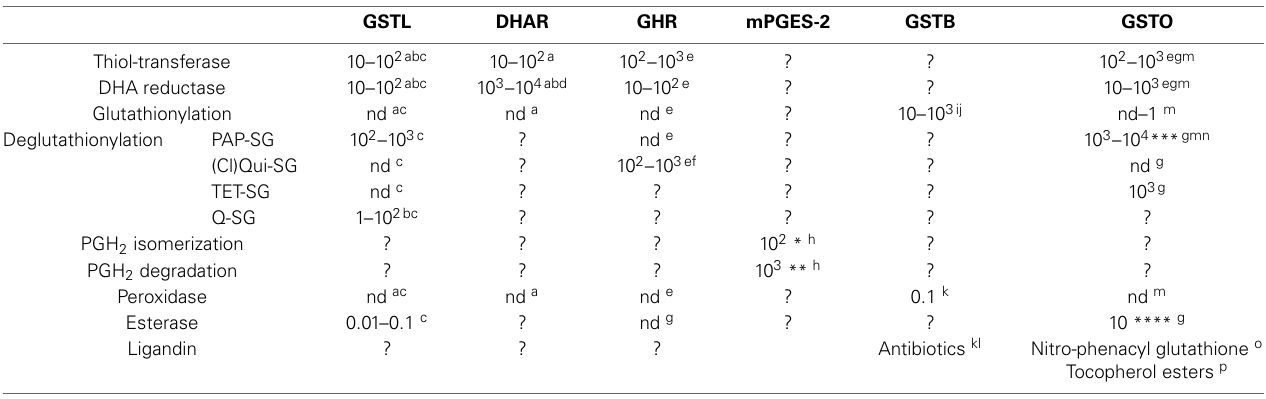
Table 5 | Enzymatic and ligandin activities detected for